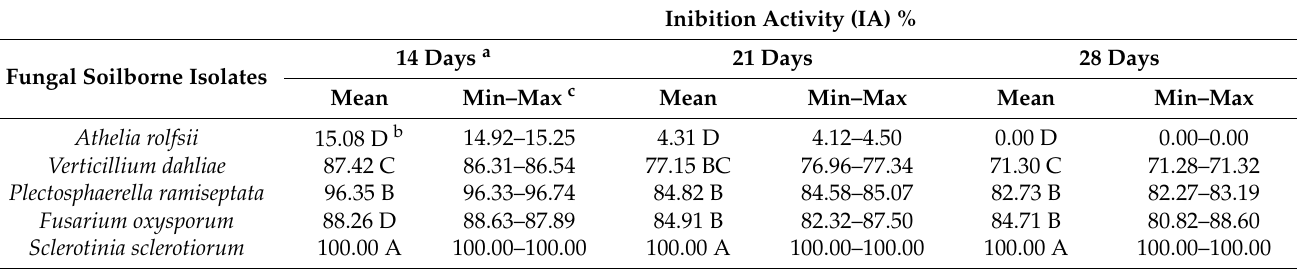
Table 1. Inhibition activity percentage (IA) by CARA17 strain against mycelial growth of soil-borne pathogens in vitro (dual cultures).